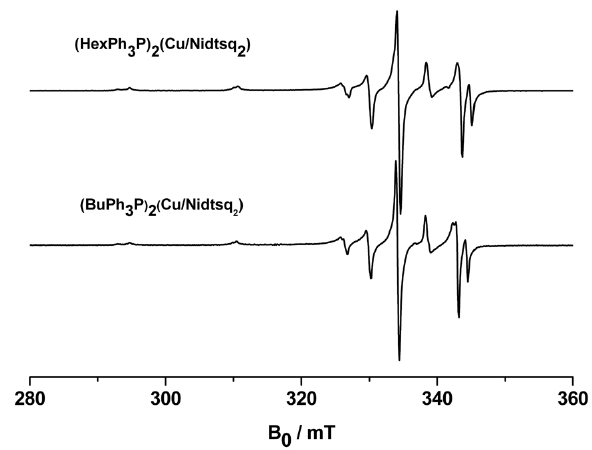
Figure 5. EPR powder spectra of the Cu(II) doped host lattices (BuPh